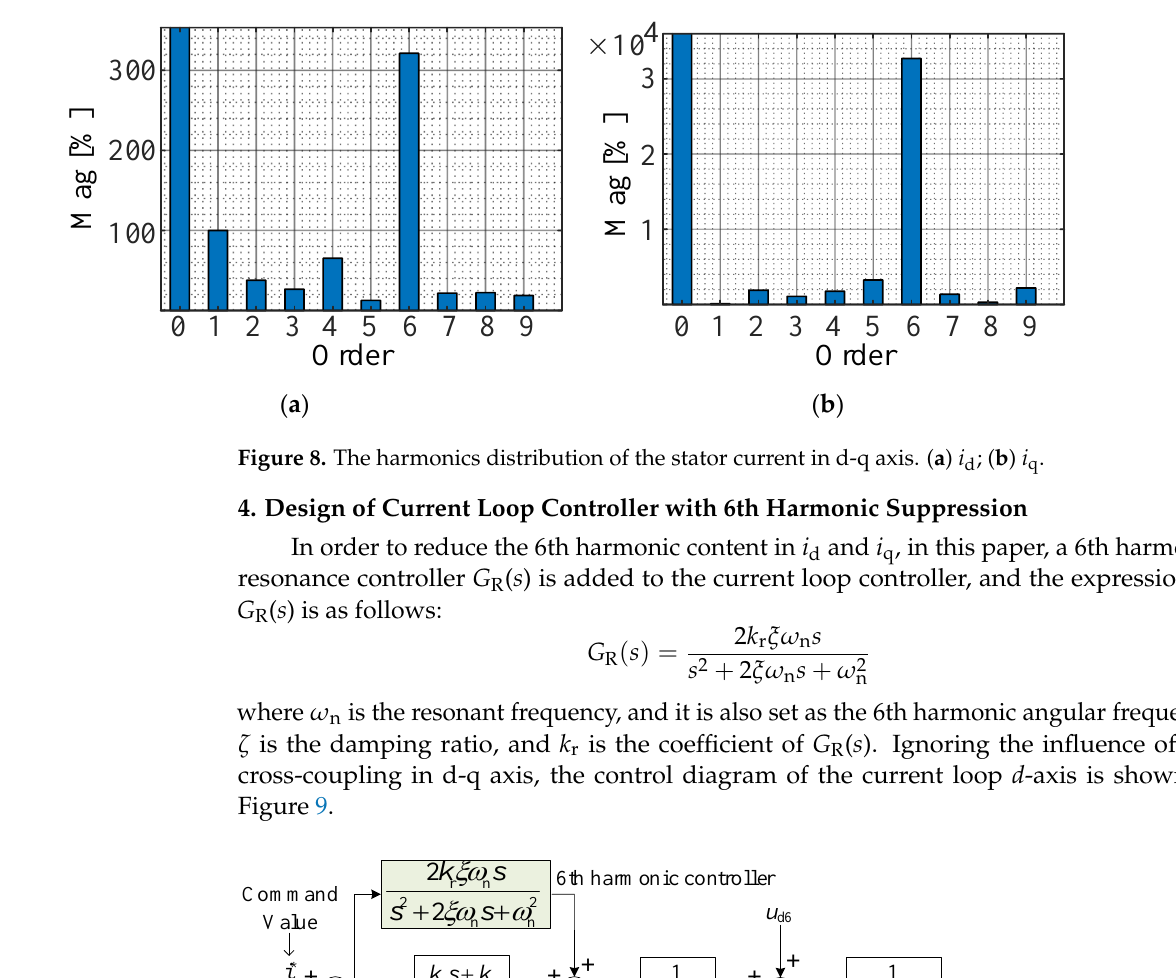
Figure 8. The harmonics distribution of the stator current in d-q axis. ( a ) i d ; ( b ) i q .